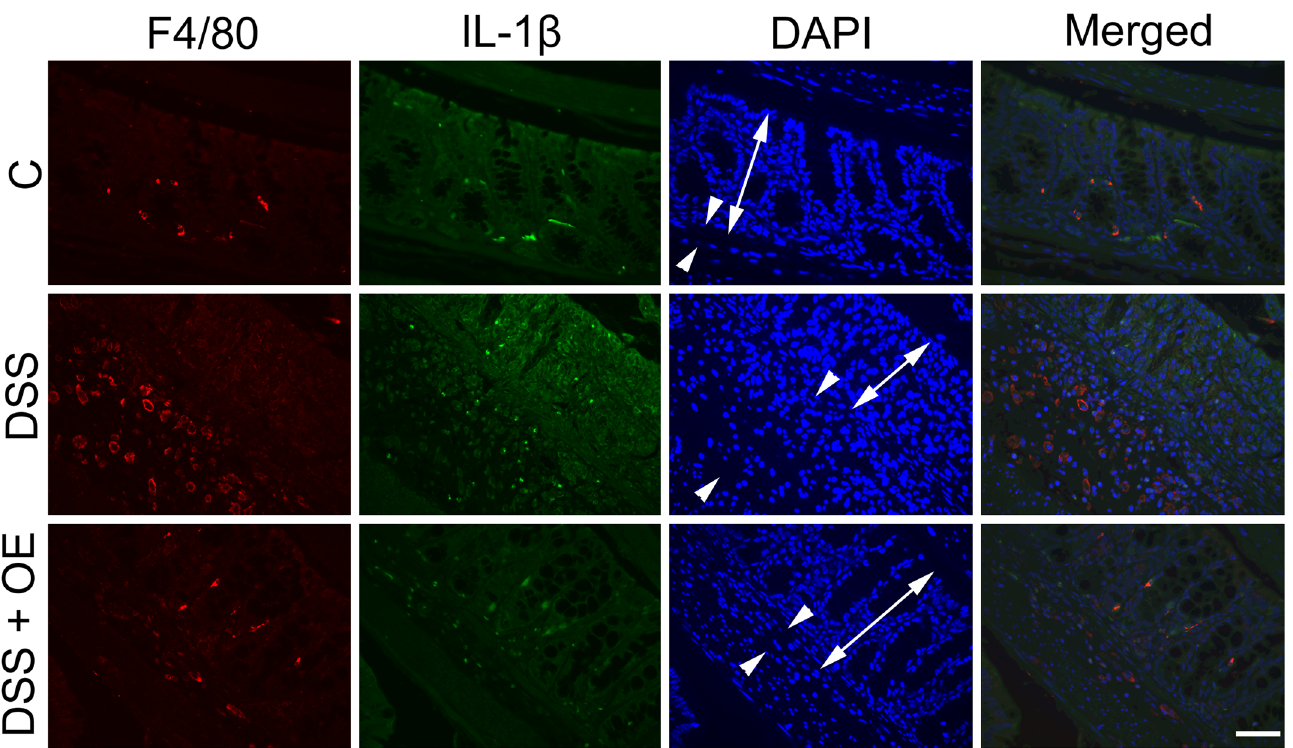
Fig 10. Effect of enoxaparin on IL-1 β expression on colon tissues. Co-immunostaining of macrophages and IL-1 β . Representative images of IL-1 β and F4/80 staining of colons from n = 3 – 5 mice. F4/80 positive cells were visualized using Alexa Fluor 594-conjugated goat anti-rat IgG (red) and IL-1 β positive cells using Alexa Fluor 488-conjugated goat anti-rabbit IgG (green). Nuclei were stained with 4 ’ ,6-diamidino-2-phenylindole (DAPI, blue). Localization of mucosa (double-headed arrow) and submucosa (arrowheads) is indicated. Scale bar = 50 μ m for 400 × magnification. Control, C; untreated colitis, DSS; colitis with oral enoxaparin, DSS+OE.